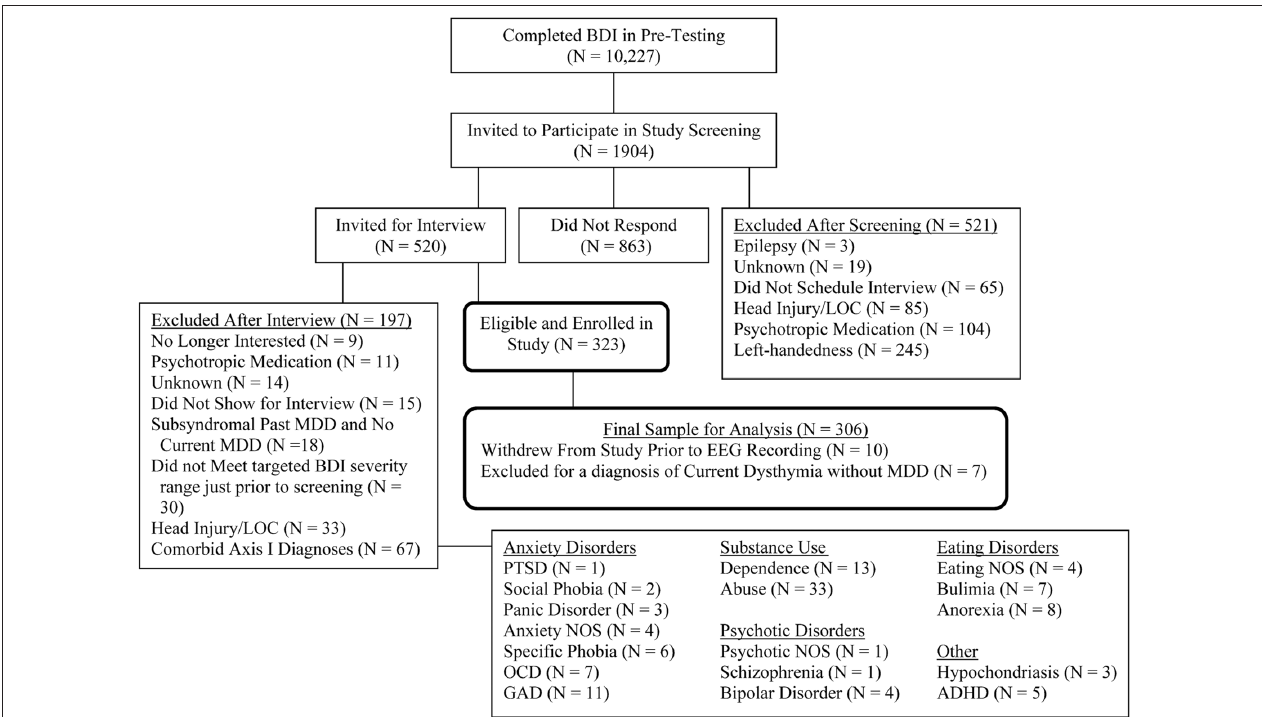
FIGuRE 1 | Flowchart of participant screening and enrollment. Note: BDI, Beck depression inventory; LOC, loss of consciousness; MDD, major depressive disorder; PTSD, posttraumatic stress disorder; NOS, not otherwise specified; OCD, obsessive compulsive disorder; GAD, generalized anxiety disorder; ADHD, attention deficit hyperactivity disorder. After Stewart et al. (2010).